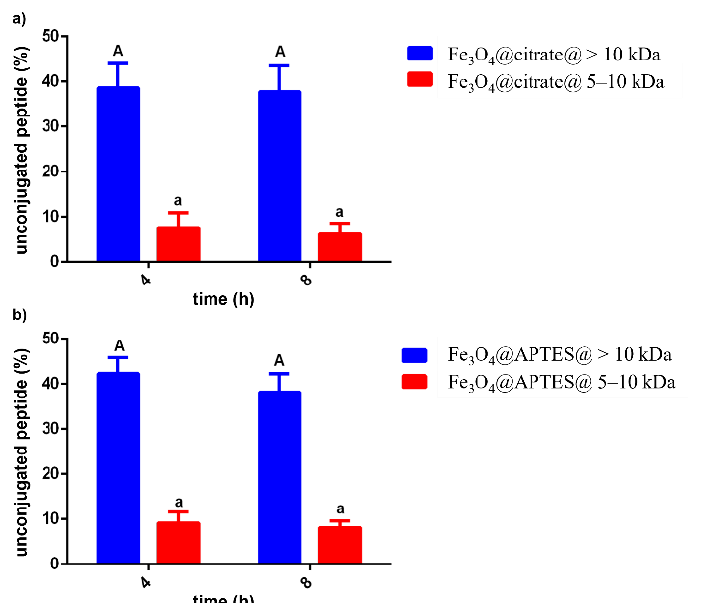
Figure 5. Percentages of unconjugated peptides to coated Fe 3 O 4 : ( a ) Fe 3 O 4 @citrate@ > 10 kDa, Fe 3 O 4 @citrate@ > 5–10 kDa; ( b ) Fe 3 O 4 @APTES@ 10 kDa, Fe 3 O 4 @APTES@ 5–10 kDa. The determinations were carried out in triplicate. The results are expressed as the means ± standard deviation. Different letters indicate statistical difference between the samples for each reaction time ( p ≤ 0.05).